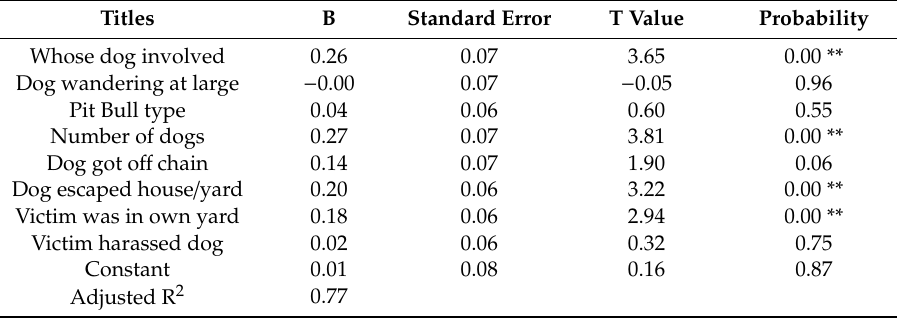
Table 3. Reduced regression, dog bites by nature of dog, and